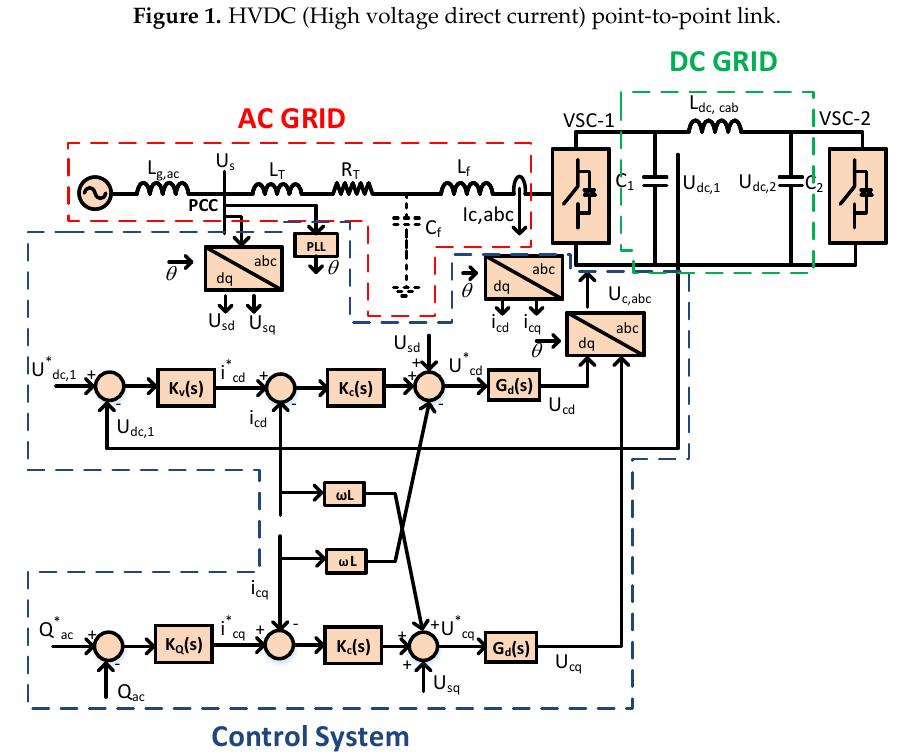
Figure 2. HVDC impedance circuit and control